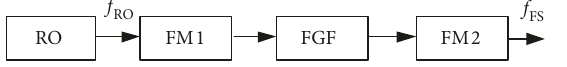
Figure 2: The generalized structural scheme of the channel for the formation of